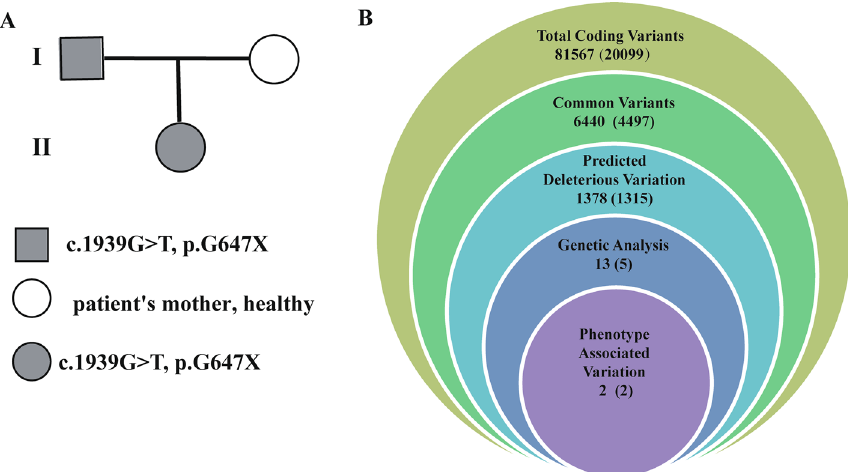
Figure 2. Family pedigree and the filtering process for WES data. ( A ) Family pedigree consists of one proband. I-1 represents the proband’s father; I-2 represents the proband’s mother; II-1 represents the proband. ( B ) The filtering process for WES data, containing 81,567 total coding variants. Filtering results: 1315 deleterious variations, two variants selected from genetic analysis, final gene associated with this phenotype variation.